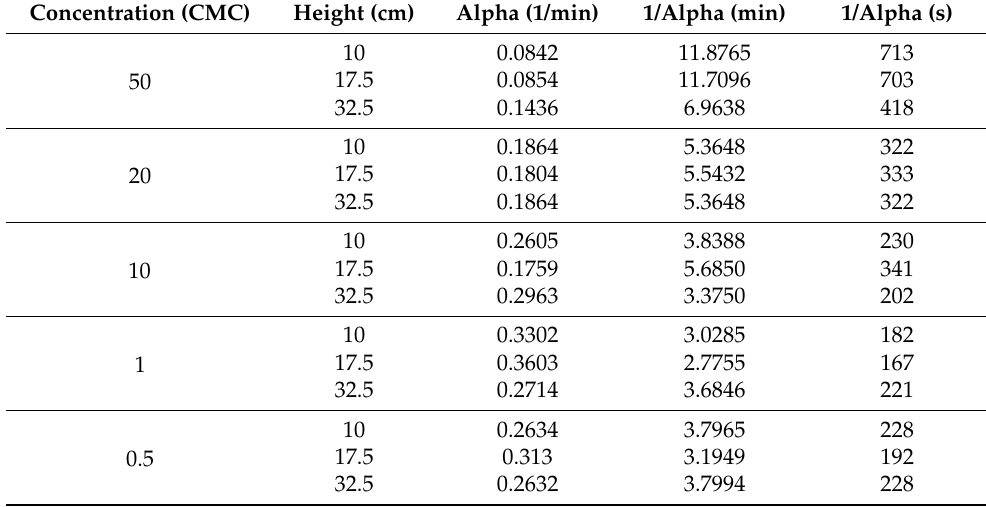
Table 5. The characteristic time scale obtained using Equation (4) for foams produced with SDS solutions with 15 dH hard water for each of the heights investigated.